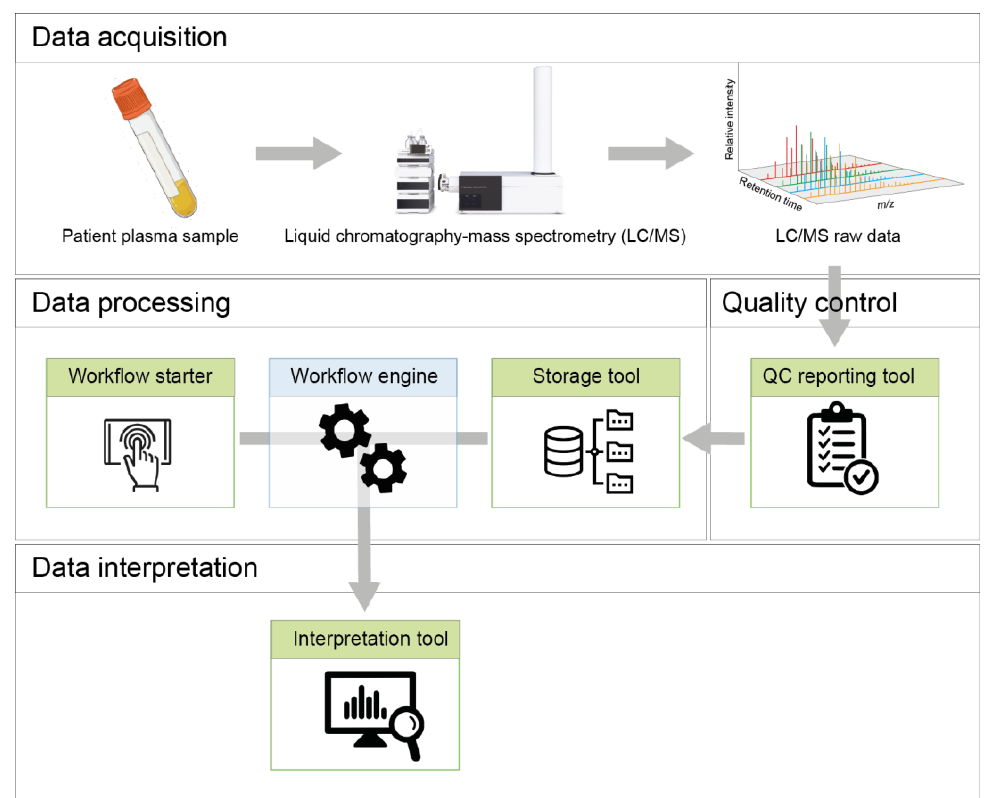
Figure 1. Schematic overview of the NGMS procedure and different tools embedded in the NGMS computational pipeline.